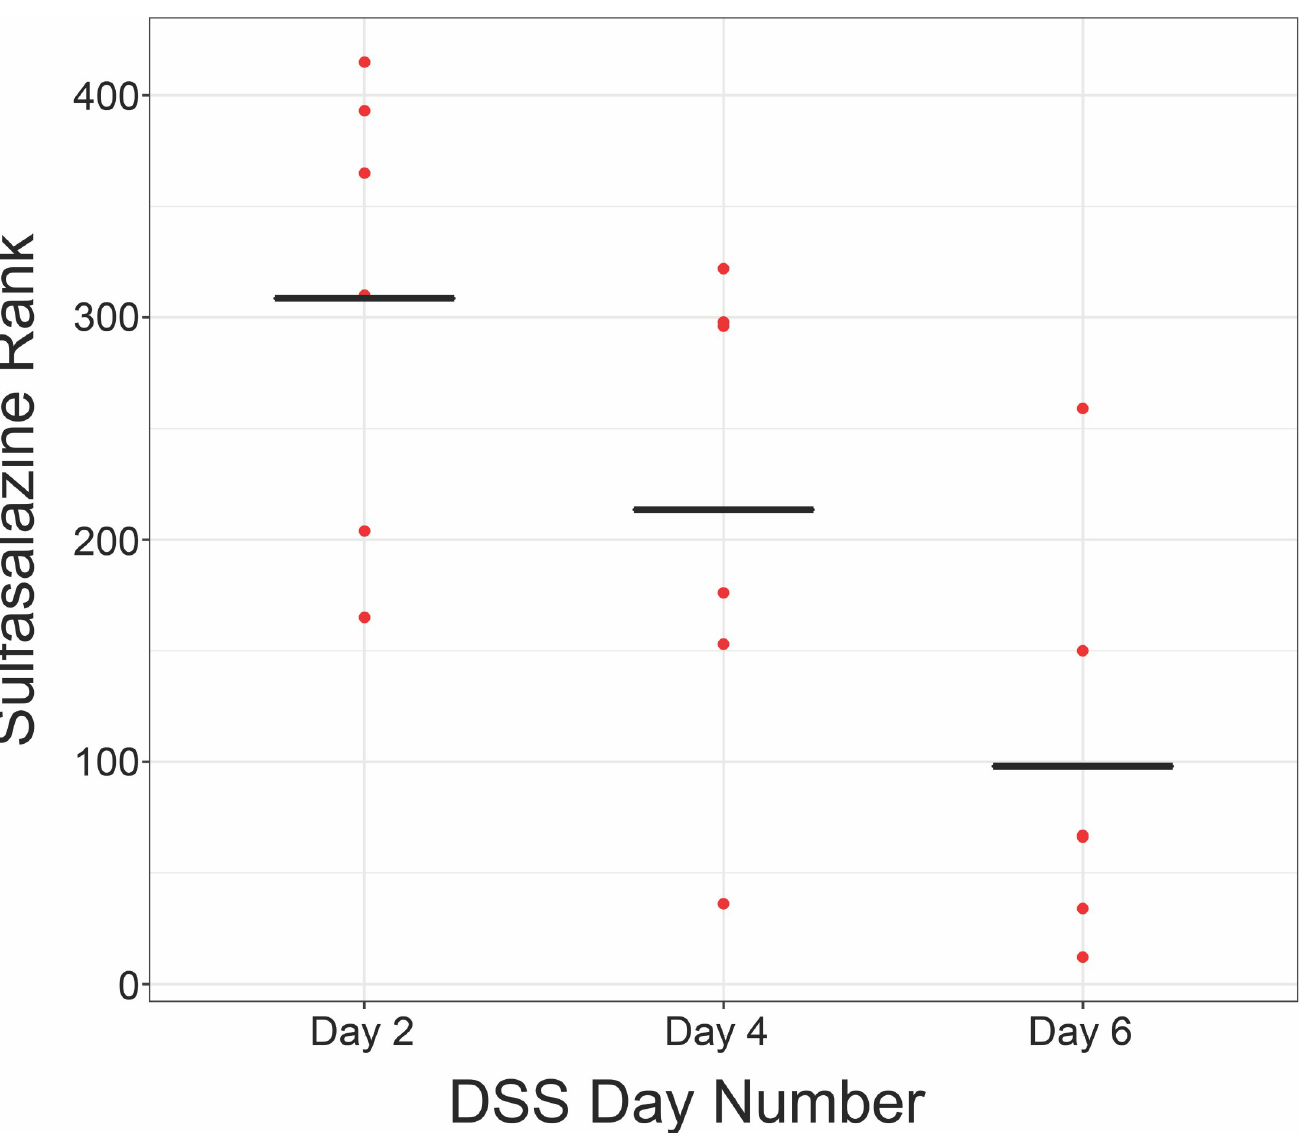
Fig 7. Sulfasalazine rank significantly decreases (p = 0.01) from day 2 to day 6 of DSS administration for mice colonic samples from GSE22307. The mean is indicated by the black